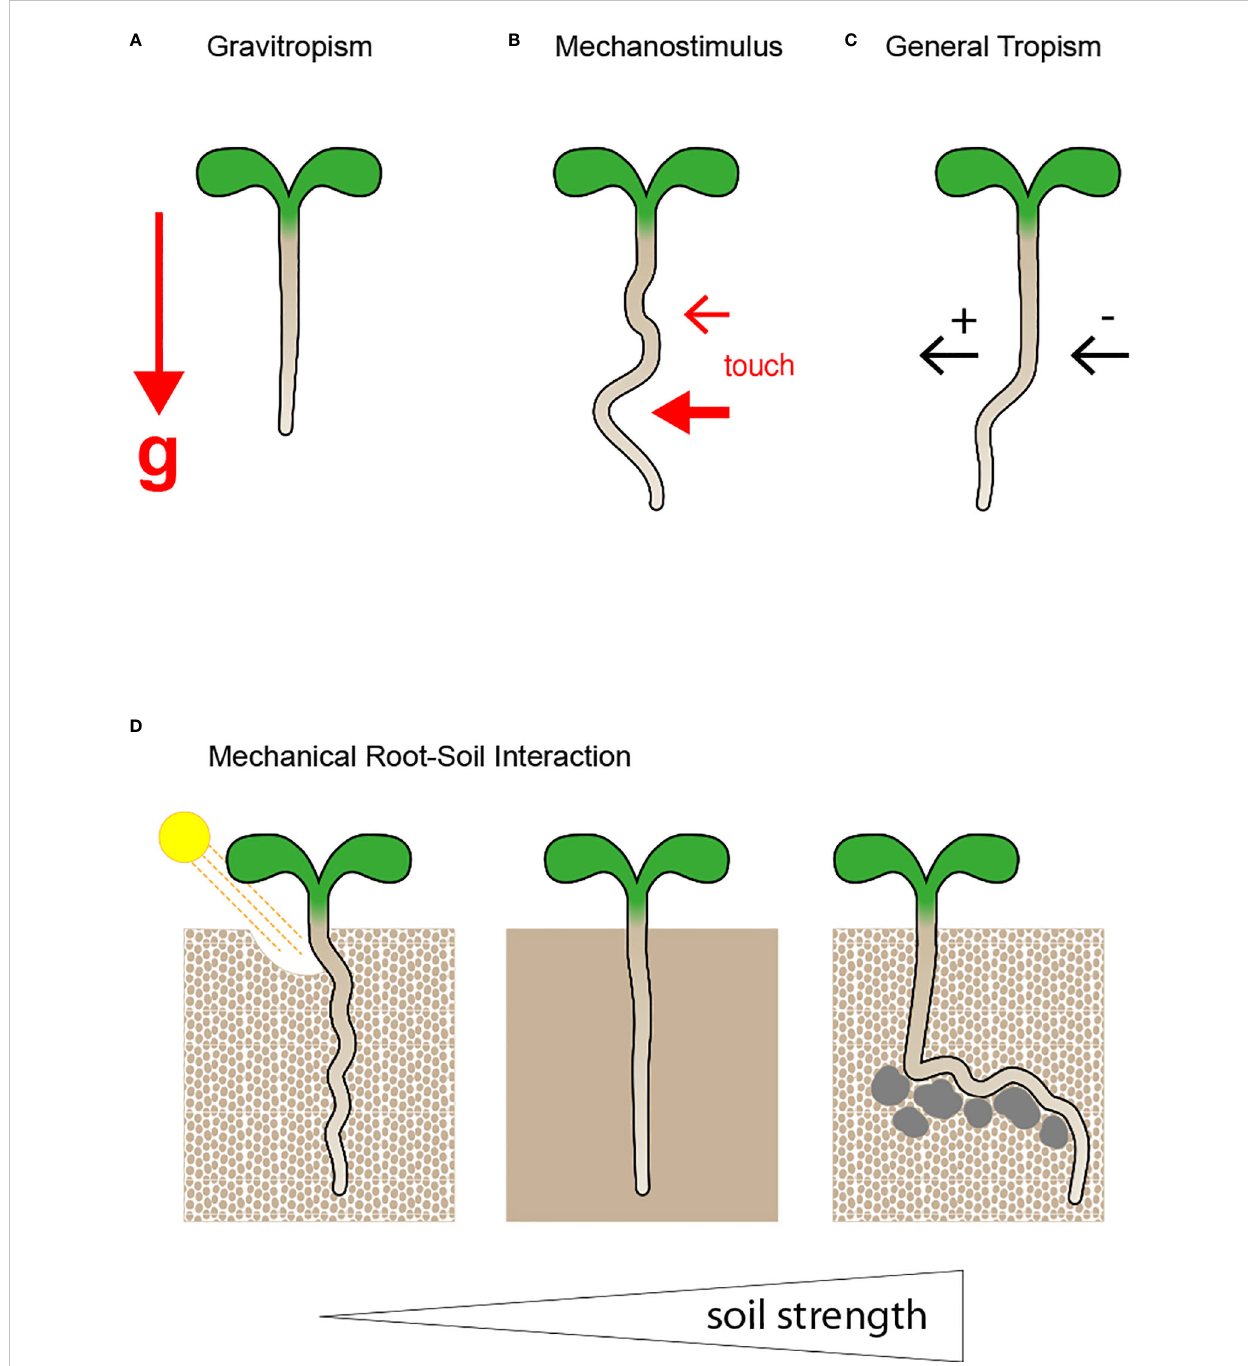
FIGURE 1 Root growth direction and pattern are modulated by manifold stimuli. (A) Roots evolved to steer growth direction along the gravity vector (g), as indicated by the red arrow. Although gravity is a continuous and constant predominant force, the soil is a heterogeneous mixture, and other exogenous stimuli result in root growth deviation. (B) Roots are exposed to diverse mechanical/touch stimuli,indicated by the red arrows, depending on the growth medium strength, and their response to the mechanical pressure de fi nes root growth pattern. (C) The soil composition is variable, and nutrients, water, indicated by the black arrows, and harmful substances are randomly distributed, wherefore the root developed to grow towards (positive tropism) or away (negative tropism) from distinct stimuli. (D) Soil can be either loose, compact or exhibit impenetrable obstacles. Roots must adjust their root growth behaviour accordingly to ef fi ciently explore their surroundings and ensure nutrient uptake and plant productivity. The root adjusts root growth behaviour to reduce soil strength. In loose soil the root is circumnutating, whereby it moves light particles aside while manoeuvring through the soil. When the soil becomes more compact the root needs to change root properties to grow through dense areas by changing its mechanical properties of the very root tip, which enhance the ef fi ciency of soil